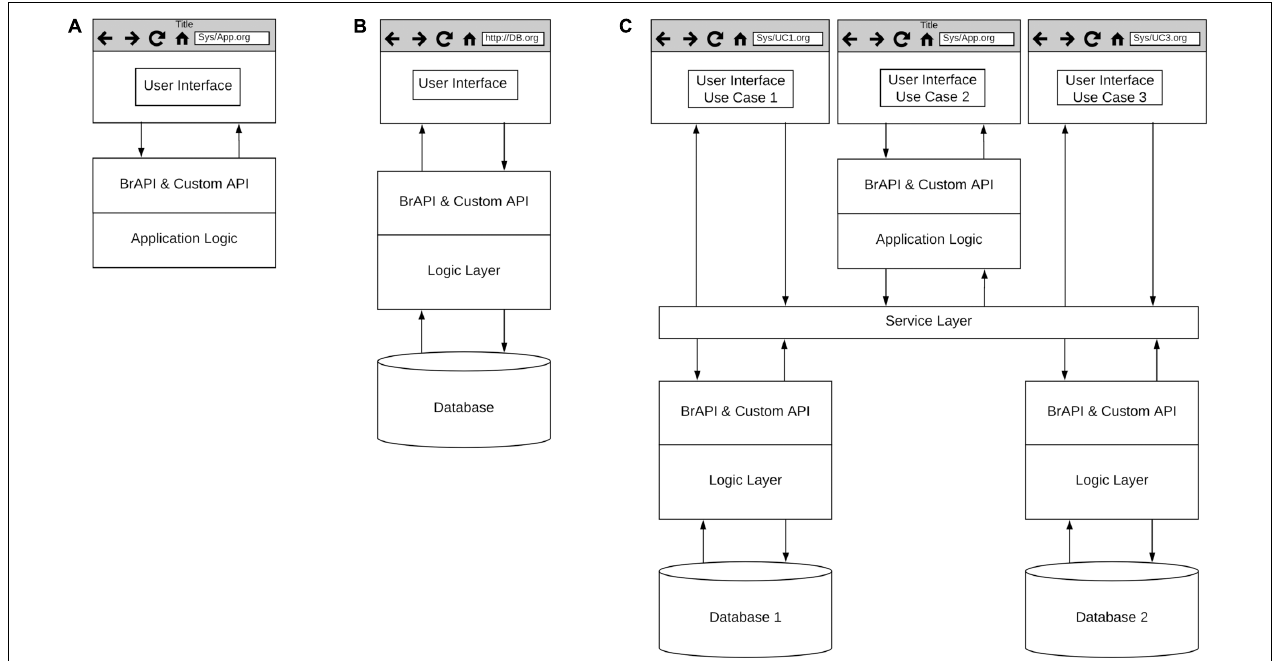
FIGURE 6 | High level architecture for breeding software. (A) Applications, (B) Databases, and (C) Breeding management systems.